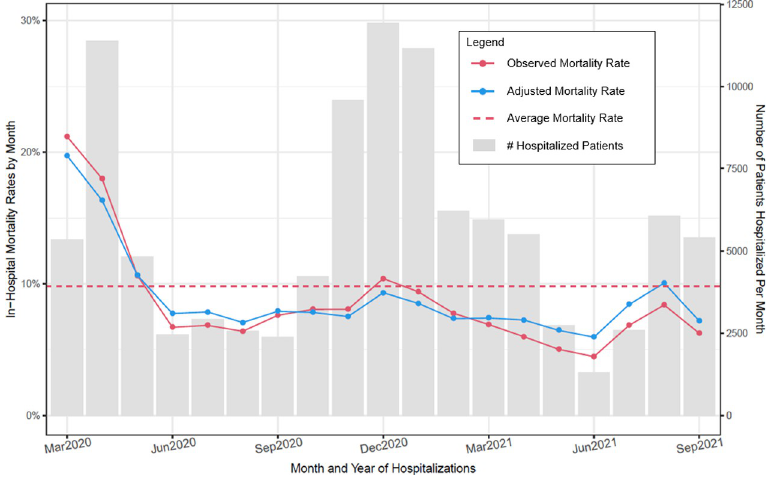
Fig 2. Observed and adjusted in–hospital mortality rates and number of patients hospitalized per month across 21 health systems (March 2020 through September 2021).